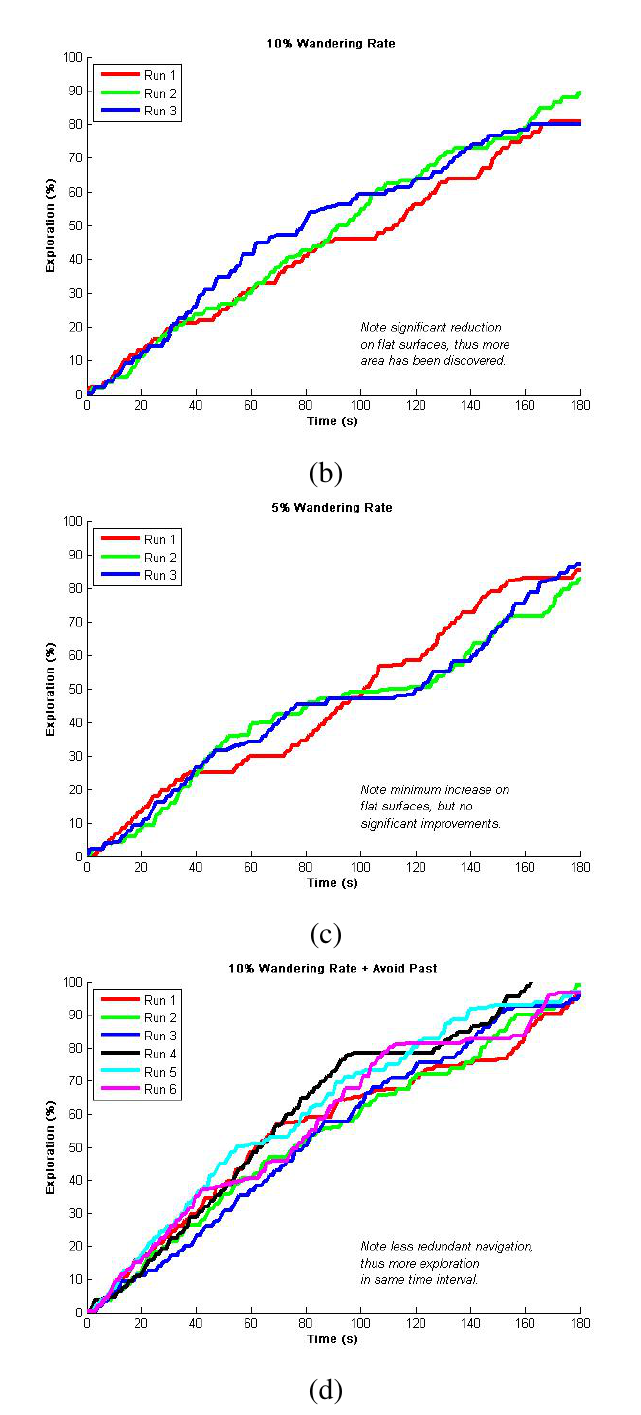
Table 2. Average and Standard Deviation for full exploration time in 10 runs using Avoid Past + 10% wandering rate with 1